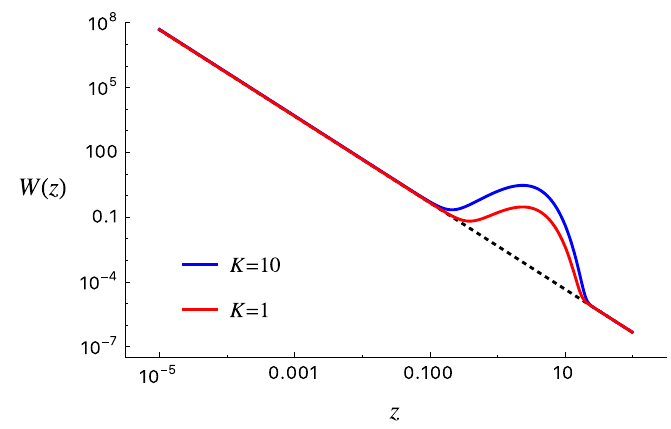
Figure 13 . This shows the dependence on z = M 1 =T of the coe(cid:14)cient W ( z ) in the Boltzmann equation for K = 1 and K = 10, with M 1 = 5 (cid:2) 10 10 GeV and the neutrino parameters in the text. The resonance peak around T ’ M 1 increases with K